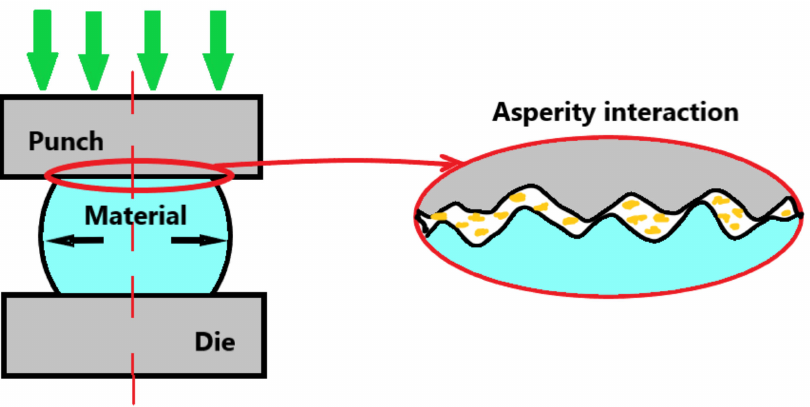
Figure 1. Surface roughness interaction between die and